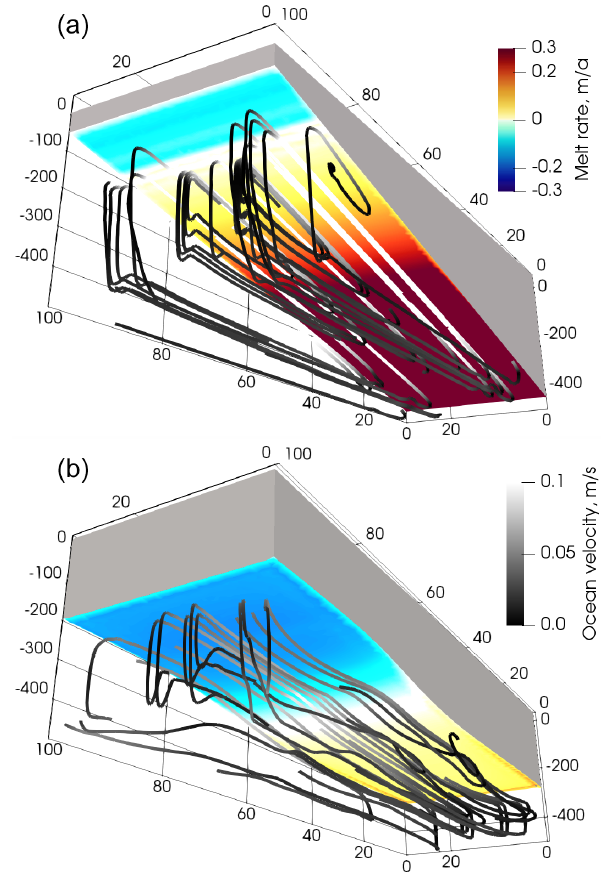
Figure 4. Coupled system state after the first (a) and last (b) cou- pling intervals from the experiment VE1_ER (Table 2). The ice shelf is shown in grey, with basal melt rate computed by the ocean shown in colour on the underside of the ice shelf. Ocean streamlines are shown beneath the ice shelf, with the greyscale indicating mag- nitude of simulated ocean velocity. The vertical coordinate is given in metres; the horizontal coordinates are given in kilometres. This was a 100-year